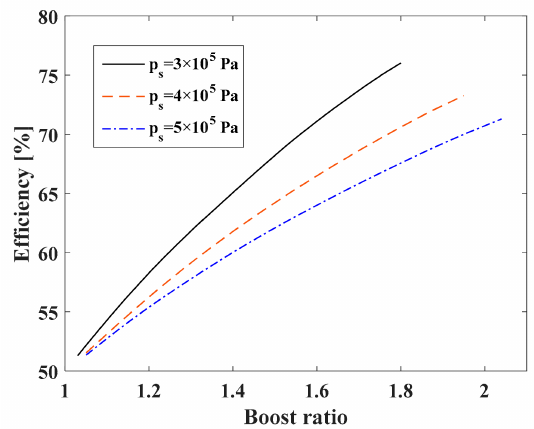
Figure 18. Efficiency under different boost ratios.